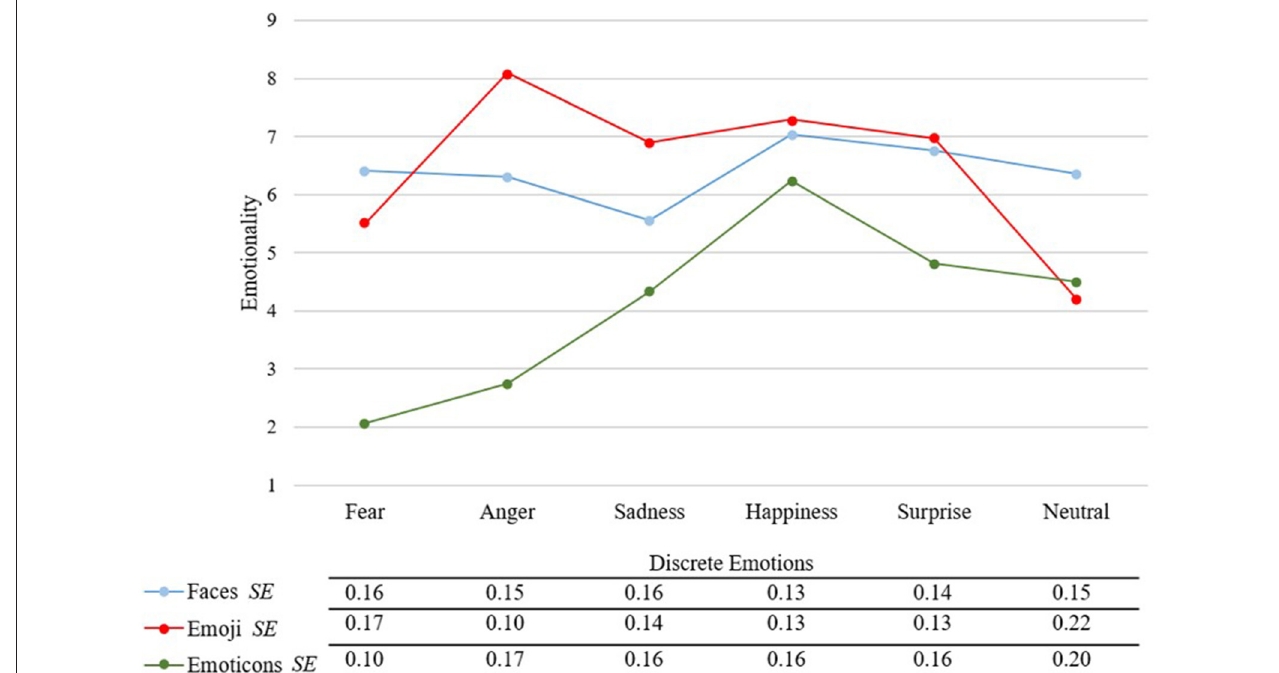
FIGURE 3 | Mean emotionality scores for each stimulus category and discrete emotion, from 1 = “not at all” to 9 = “totally” and standard errors ( SE ).